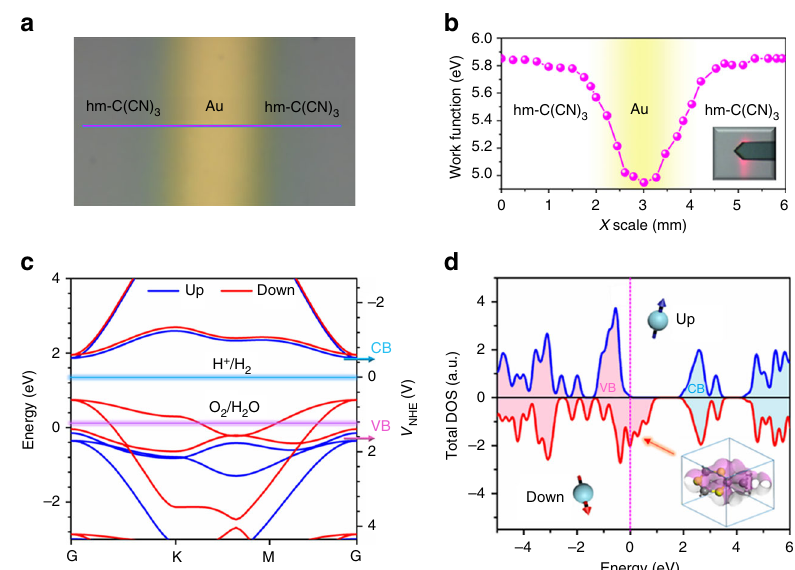
Fig. 2 Electronic structure of hm-C(CN) 3 nanosheets. a Photograph of the hm-C(CN) 3 nanosheet fi lm patterned with the Au line for the scanning Kelvin probe measurement. b Line-scan data show the Fermi level of hm-C(CN) 3 at each position on the purple line in a . c Band structure for hm-C(CN) 3 . The position of the reduction level for H + to H 2 is indicated by the dashed blue line and the oxidation potential of H 2 O to O 2 is indicated by the purple dashed line just above the valence band. The blue and pink arrows represent the CB and VB positions of hm-C(CN) 3 nanosheets which acquired from the experiment. d Spin-resolved total density of state for hm-C(CN) 3 . The short pink dotted line indicates the Fermi